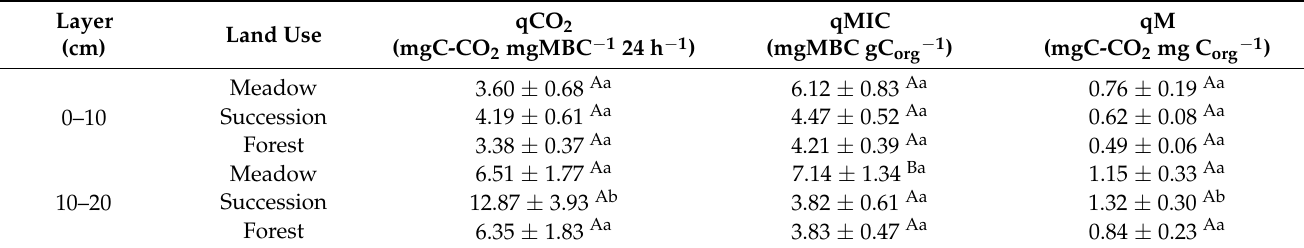
Table 3. Mean and standard error values of metabolic quotient (qCO 2 ), microbial quotient (qMIC) and mineralization quotient (qM) results. The lowercase letters indicate differences between examined soil layers for individual land-use variants, while uppercase letters show differences between land-use variants separately for the 0–10 and 10–20 cm soil layers (Tukey post hoc test, p < 0.05). Standard error is reported behind “ ± ”.